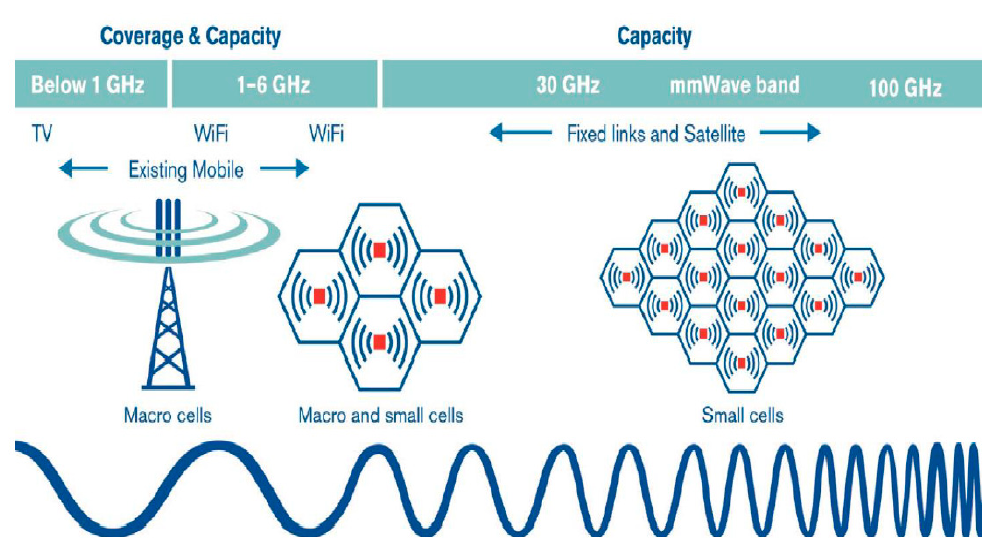
Figure 5. Spectrum ranges for 5G [32].